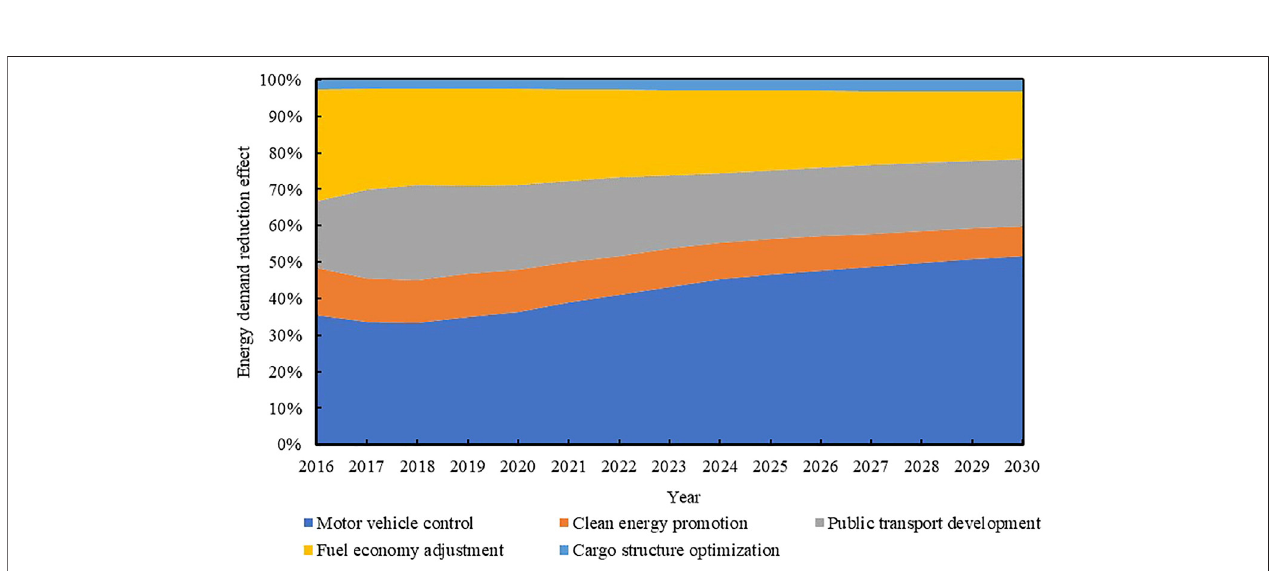
FIGURE 4 | Proportion of energy demand reduction for different measures under a low-carbon scenario for the road and marine transportation sectors in Guangdong Province.